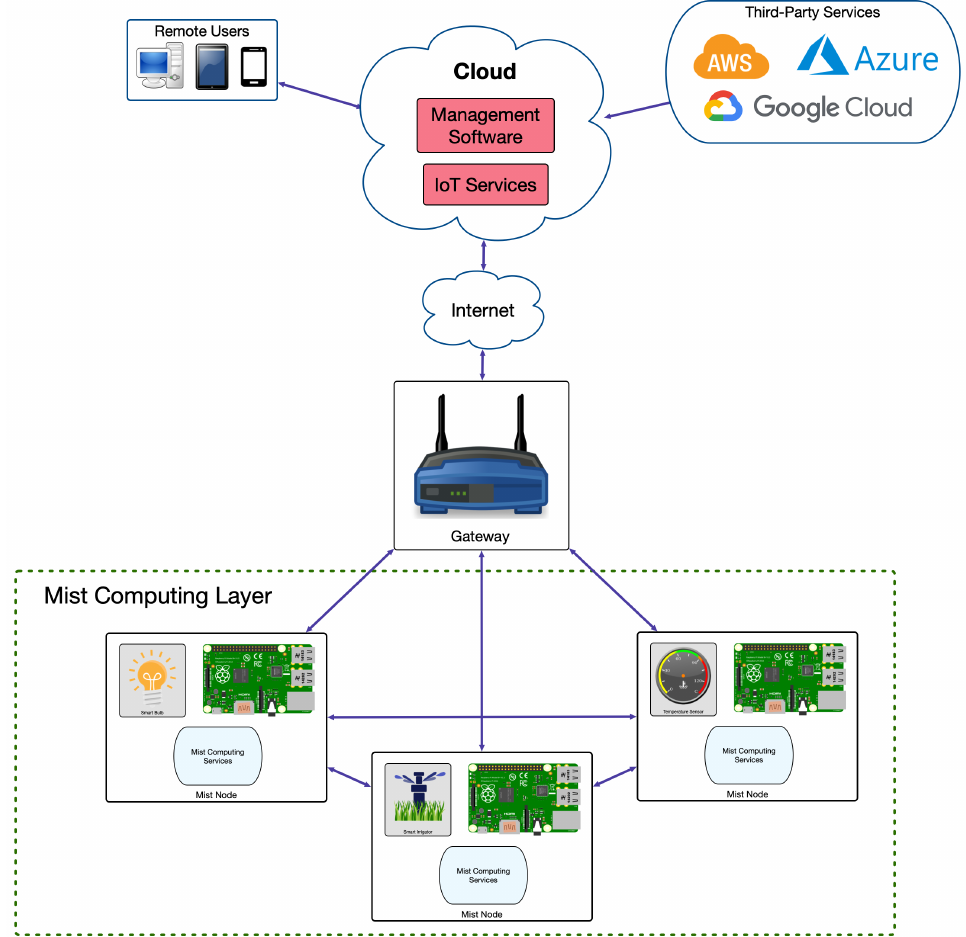
Figure 3. Example of mist computing